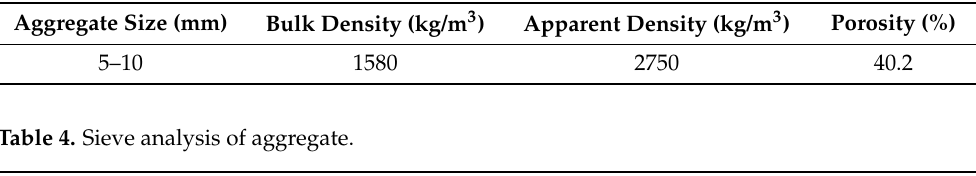
Table 3. Physical properties of aggregate.